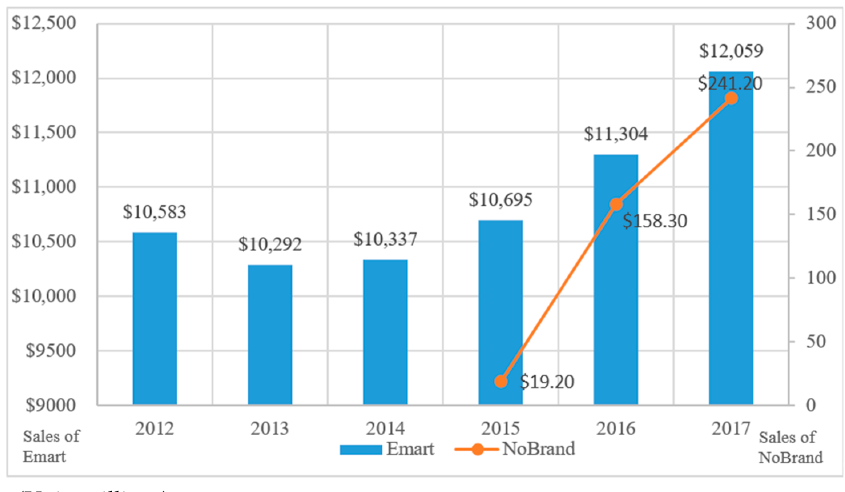
Figure 1. Emart and NoBrand Sales (USD). Source: Economychosun (2018) [31].